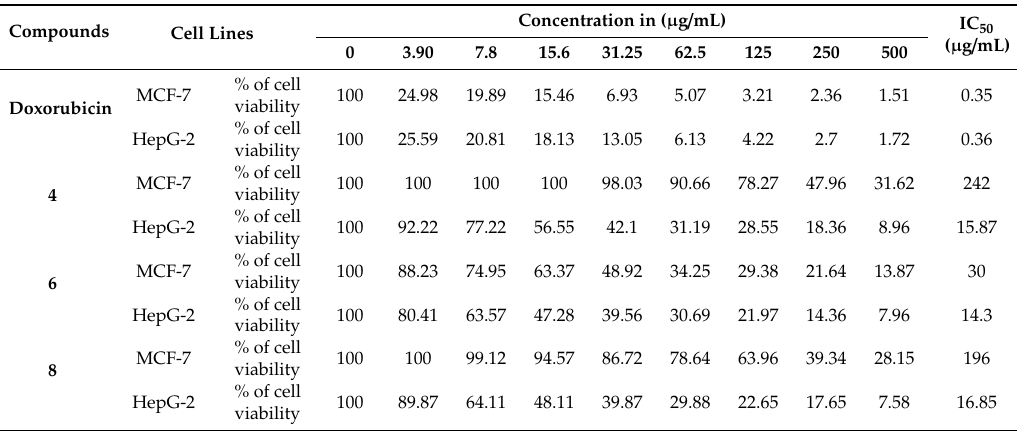
Figure 2. Effect of various concentrations of tested compounds on MCF-7 cell Inhibition activity. (1) Control MCF-7 (2) compound 14 (500 µg/mL), (3) compound 6 (7.8 µg/mL), (4) compound 6 (500 µg/mL), (5) compound 12 (7.8 µg/mL), (6) compound 12 (31.25 µg/mL), and (7) compound 12 (500 µg/mL). Table 1. E ff ect of treatment at various concentrations of prepared compounds on MCF-7 and HepG-2 cell